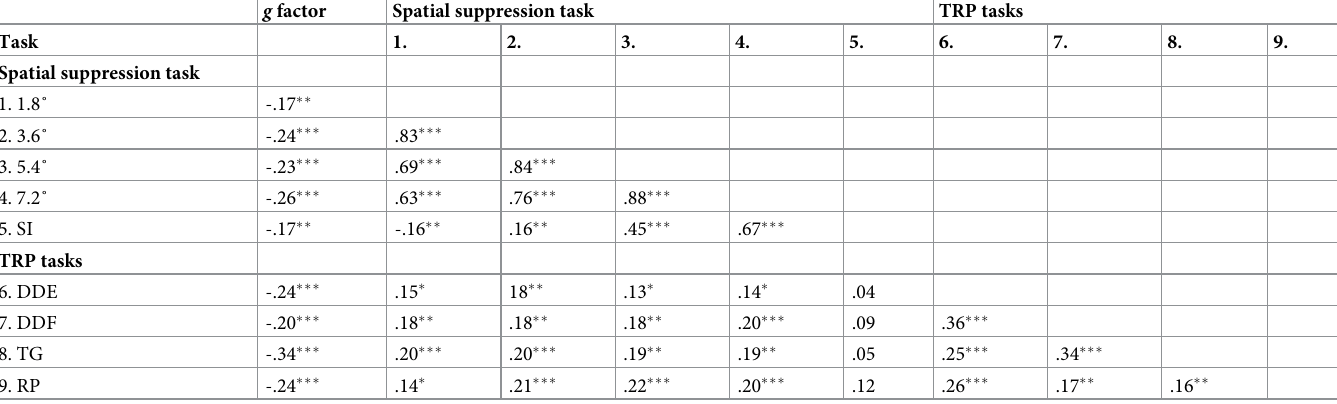
Table 2. Pearson correlations between psychometric intelligence ( g factor), spatial suppression task, spatial suppression index, and temporal resolution power tasks. g